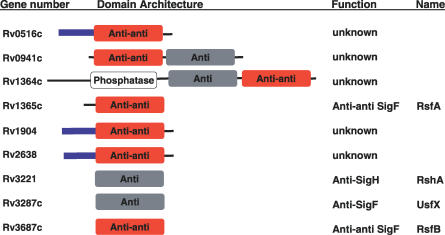

Mtb Proteins Containing Domains Homologous to the B. subtilis Alternative Sigma Factor Regulators SpoIIAA and SpoIIABFour of the Mtb homologs of the B. subtilis SpoIIAB (anti–sigma factor) or SpoIIAA (anti-anti–sigma factor) encode proteins that have been shown to regulate SigF or SigH. Rv0941c contains both types of domain, and Rv1364c contains both domains as well as an RsbU-like, Ser/Thr phosphatase domain. Three of the seven anti-anti–sigma factor domains are preceded by a Ser/Thrrich N-terminal extension (blue). This extension in Rv0516c contains the site of PknD phosphorylation.